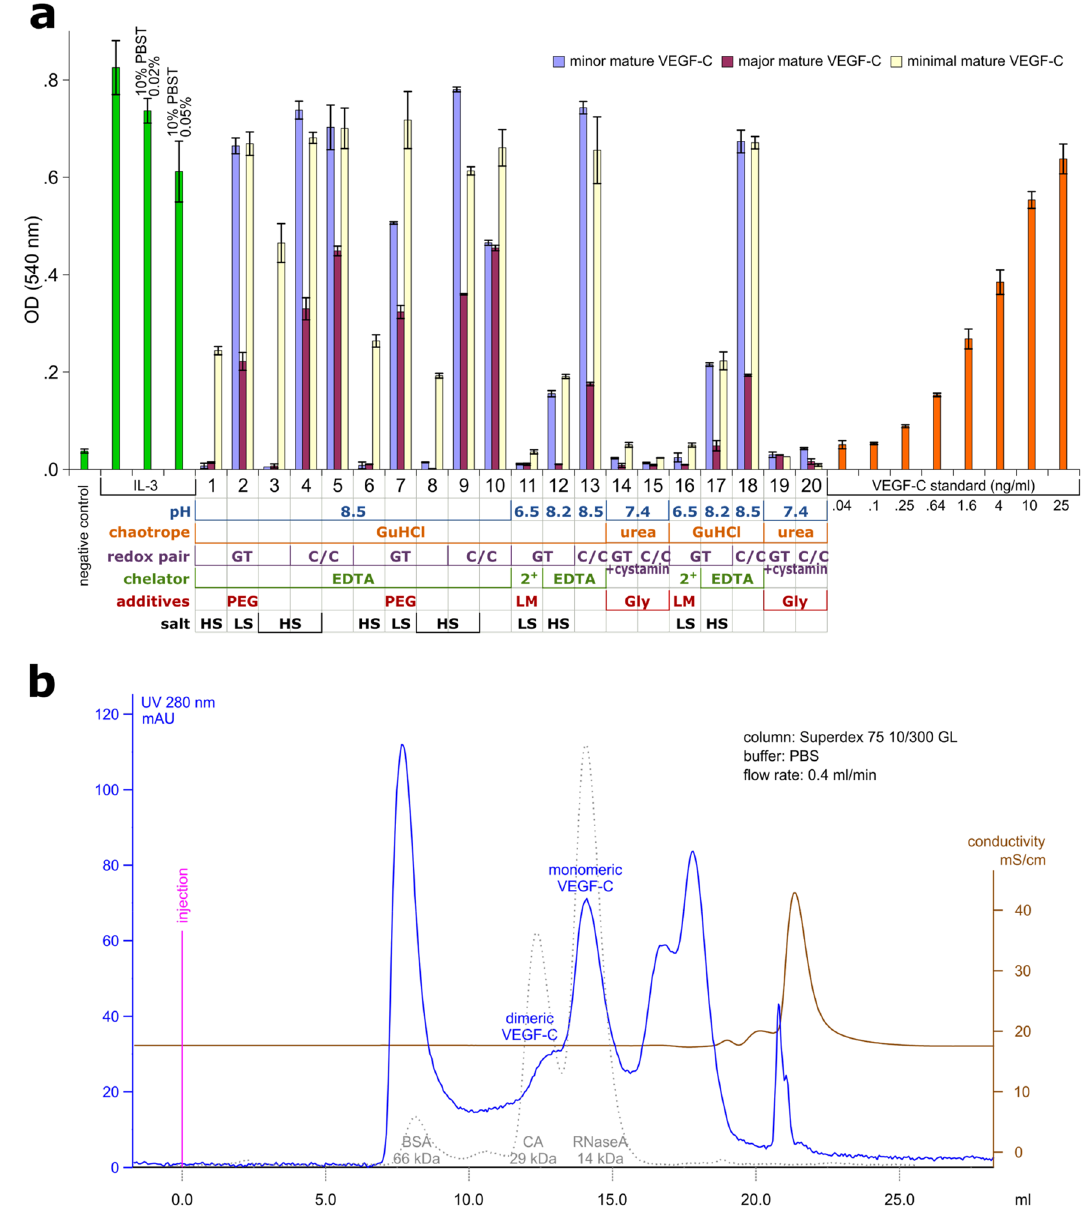
Figure 8. Ba/F3-hVEGFR-3/EpoR bioassay and size-exclusion chromatogram of refolded VEGF-C inclusion bodies (fourth/final screen). ( a ) The Ba/F3-hVEGFR-3/EpoR cell line requires supplementation with either IL-3 or VEGF-C for survival, which was measured 48 h after adding the refolding samples at a concentration of 10% by the ability to metabolize 3-(4,5-dimethylthiazol-2-yl)-2,5-diphenyltetrazolium bromide (MTT). Three different forms of mature VEGF-C were analyzed and compared to a VEGF-C protein standard produced in insect cells 26 . GuHCl guanidine hydrochloride, GT glutathione, C/C cysteine/cystine, EDTA ethylenediaminetetraacetic acid, 2 + Mg2+/Ca2+ 2.2 mM, PEG polyethylene glycol, Gly glycine, LM lauryl maltoside, HS high salt, LS low salt. (n = 2) Error bars indicate ± SD. ( b ) After removing material that had been precipitating during the refolding, the sample was resolved by size exclusion chromatography on a Superdex 75 10/300 GL column (GE Healthcare). The active, dimeric peak represented only a minor fraction of the total